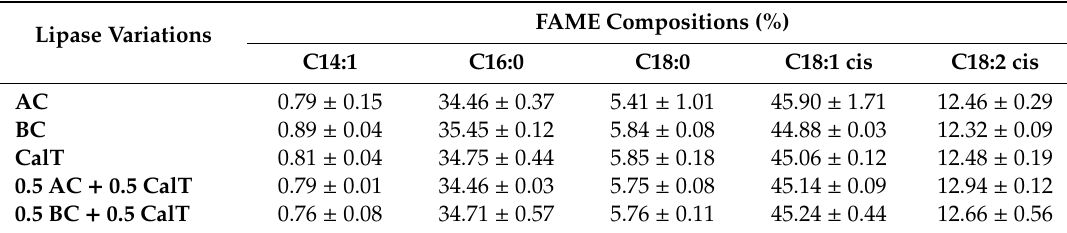
Table 3. FAME profiles of transesterification results.